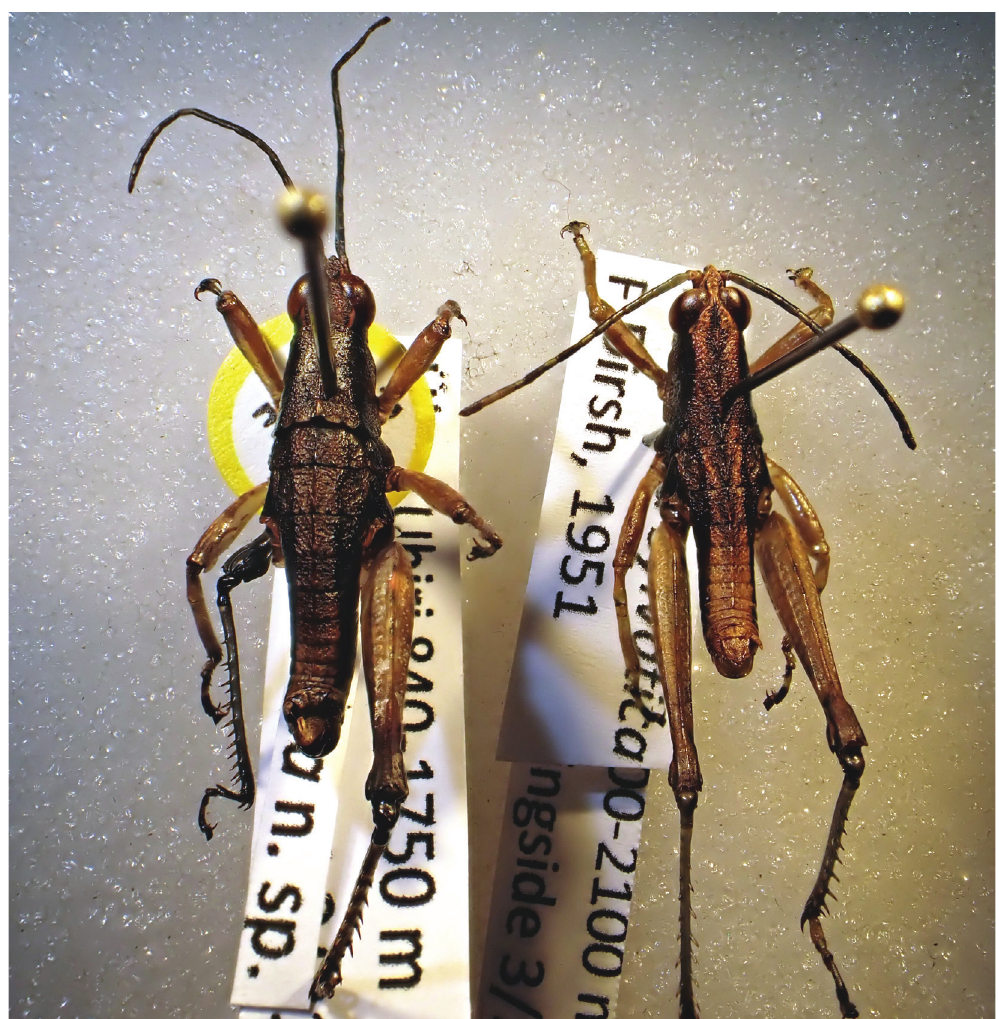
Fig. 2. Male of Burttia species. Left: B. caerulea sp. nov.; right: B. sylvatica . B. caerulea sp. nov. is larger and stouter than B. sylvatica